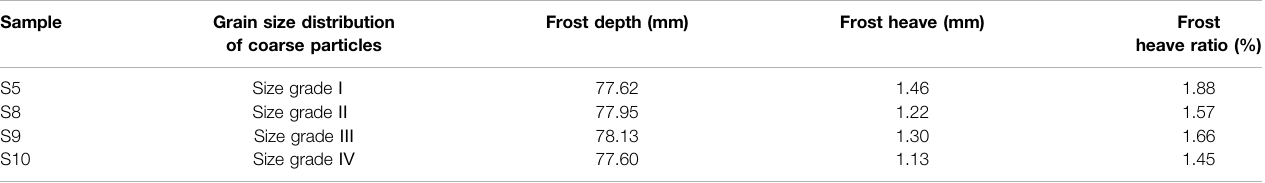
TABLE 4 | Test results for samples S5 and S8 − S10 after freezing for 144 h.